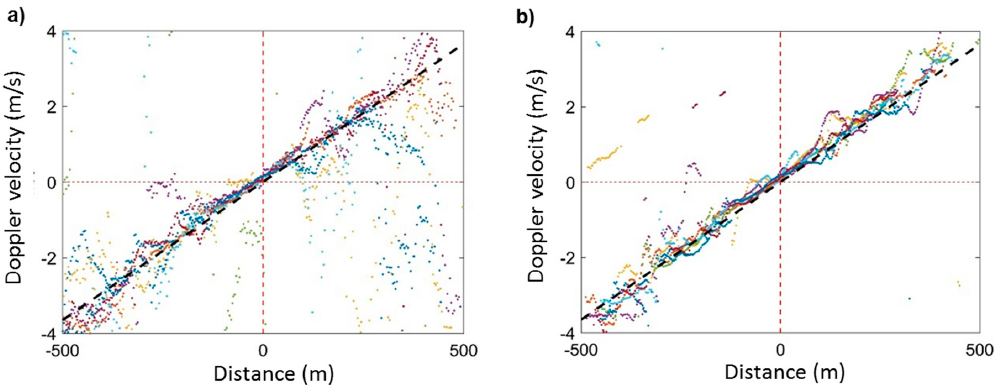
Figure 7. ( a ) Doppler velocity estimation for J = 1 lag; and ( b ) Doppler velocity estimation for J = 5 lags.